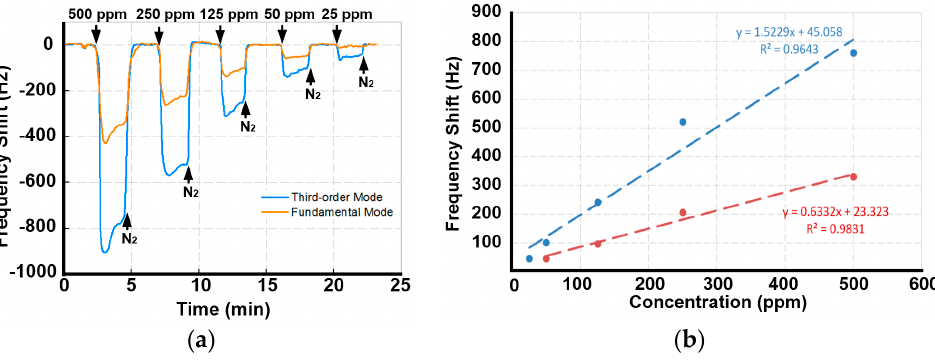
Figure 3. ( a ) Real-time responses of the first and third order WE modes of the trimethoxy (octadecyl) silane (OTES)-modified PSBAR to low-concentration ethanol vapors; ( b ) Sensitivities of the two sensing modes. R 2 is the correlation coefficient.